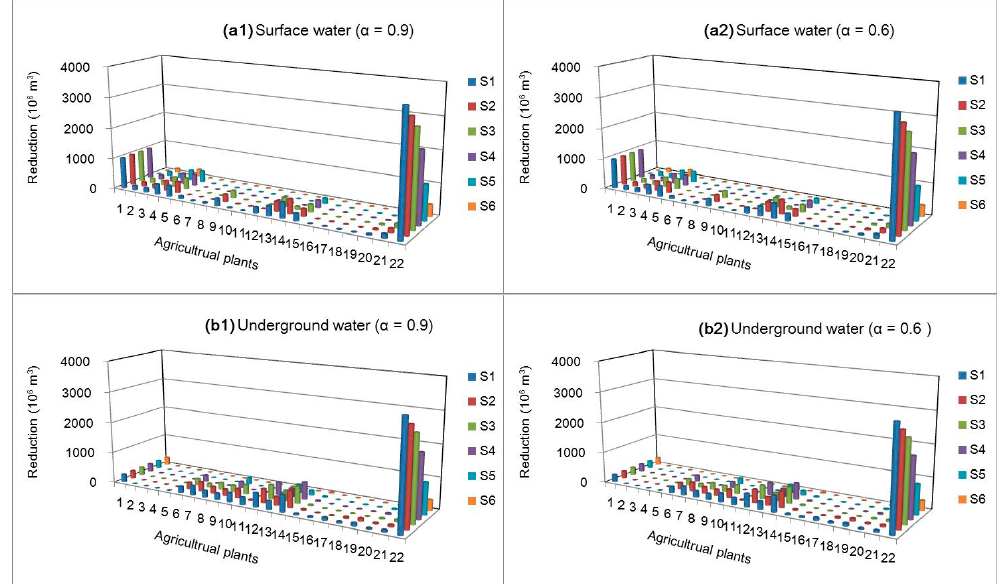
Figure 6. Reduced water rights from different sources for agricultural users under various scenarios.